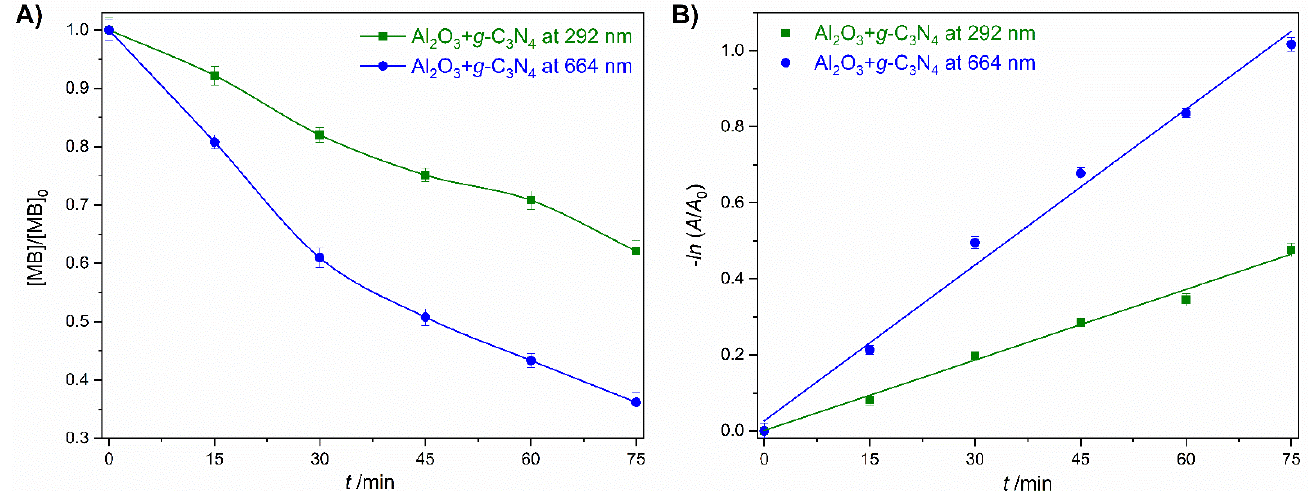
Figure 8. ( A ) Decolourisation (664 nm) and mineralisation (292 nm) of MB as a function of irradiation time under simulated solar irradiation and ( B ) plotted first-order rate constant ( k ).